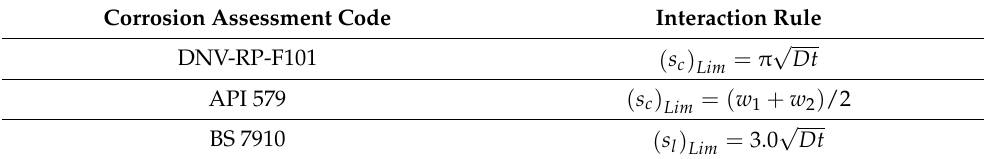
Table 1. Interaction rules applied in common corrosion assessment methods